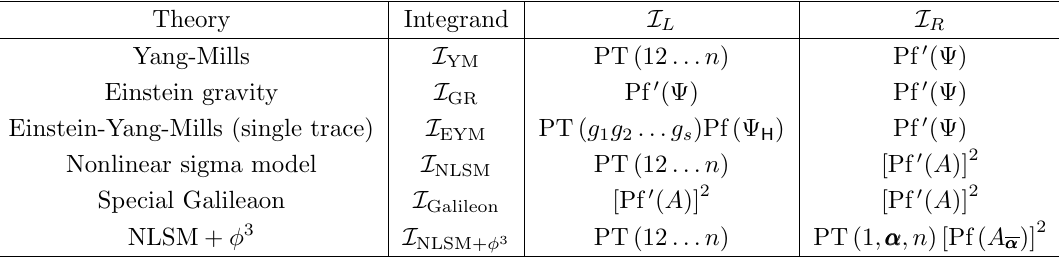
Table 1 . CHY integrands to be used in this paper. The notations will be explained when appear in the main